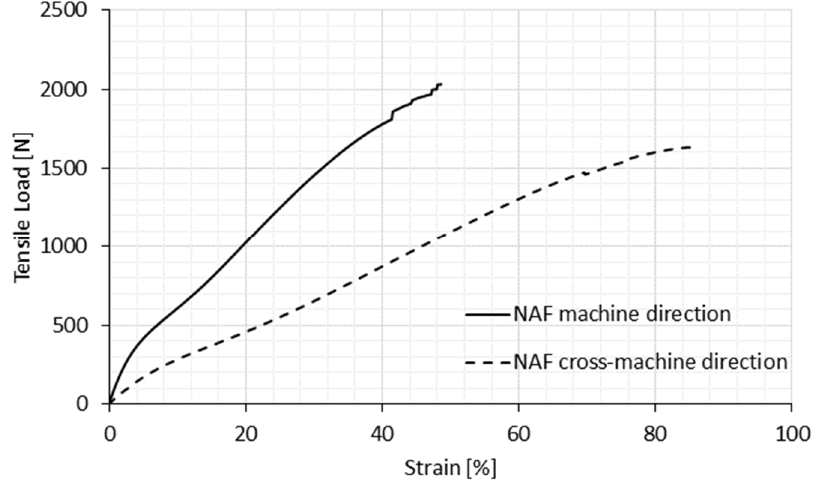
Figure 2. Tensile behavior of non-auxetic compound fabric (longitudinal deformation).